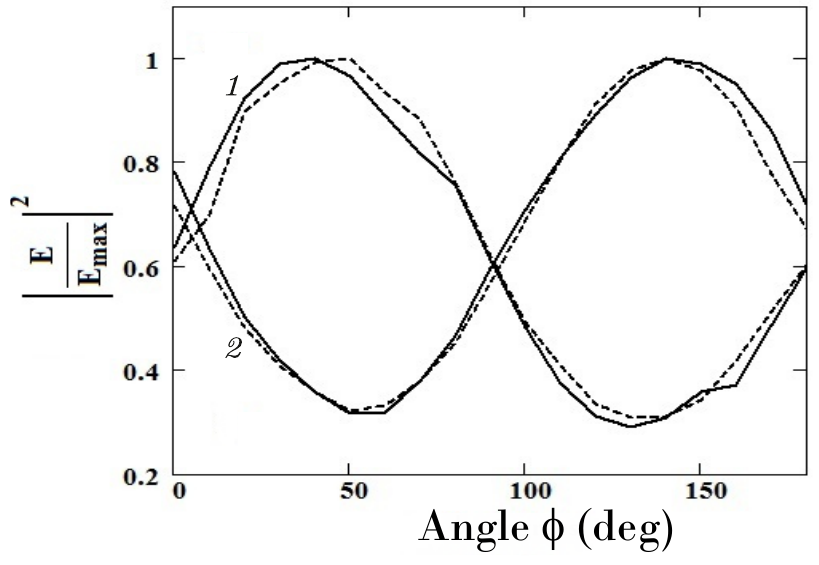
Figure 14. Square of the normalized amplitude of the signal received by the composite horn antenna as a function of the rotation angle φ at 1.55 GHz (solid line) and 1.575 GHz (dashed line).